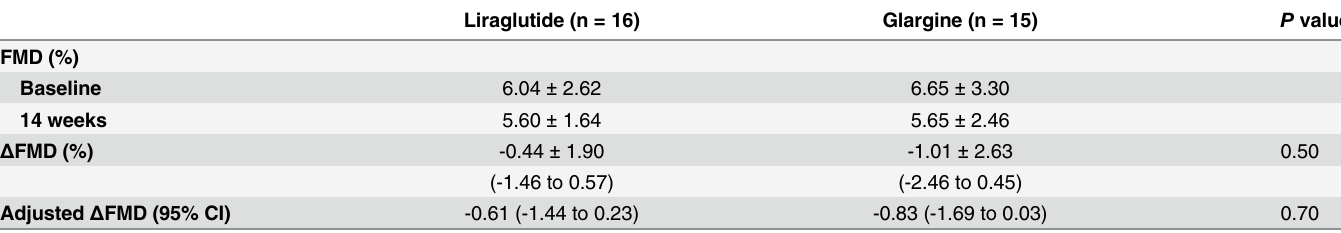
Table 2. Comparison of changes in %FMD before and after treatment in each